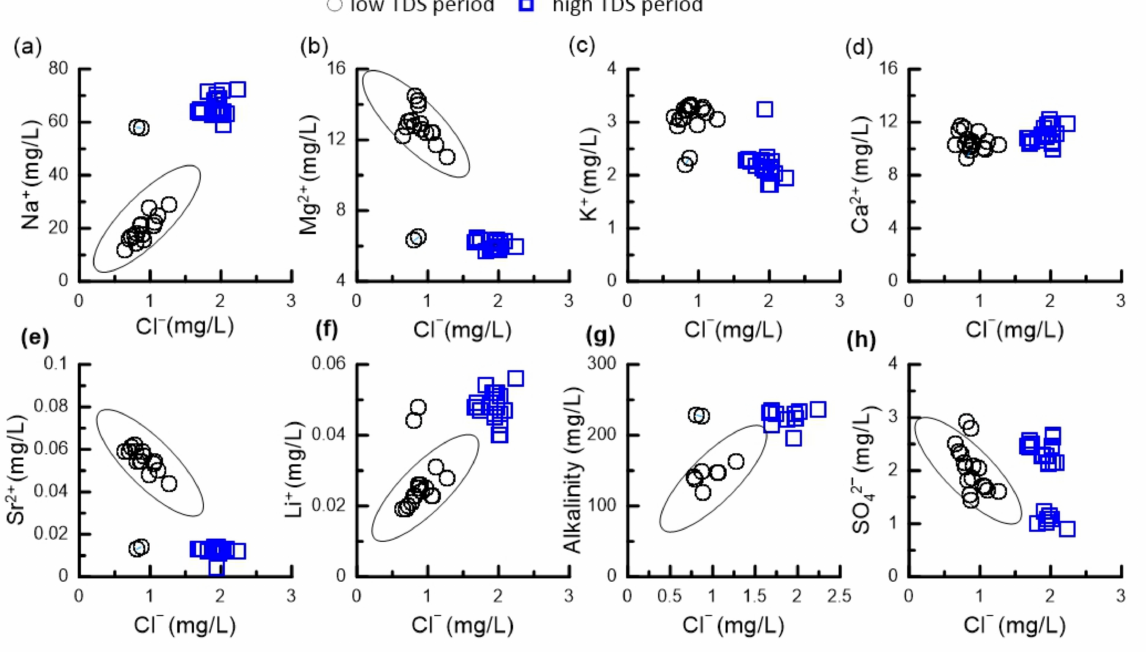
Figure 7. Relationship between chloride and ( a ) Na + , ( b ) Mg 2+ , ( c ) K + , ( d ) Ca 2+ ( e ) Sr 2+ ( f ) Li + ( g ) alkalinity and ( h ) SO 4 2 − ion in the BDS bottled